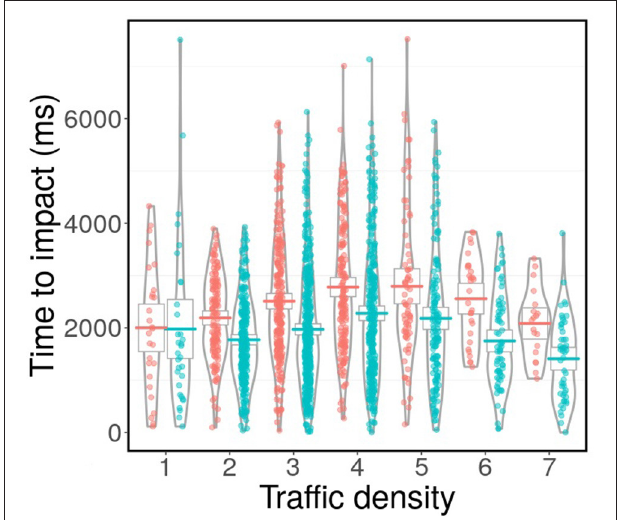
FIGURE 2 | The TTI results for the interaction between age group and traffic density. Red points indicate older adults and blue points indicate younger adults. The plot was created using a combination of the ggplot2 and ggpirate packages in R (Wickham, 2016; Braginsky, 2021).